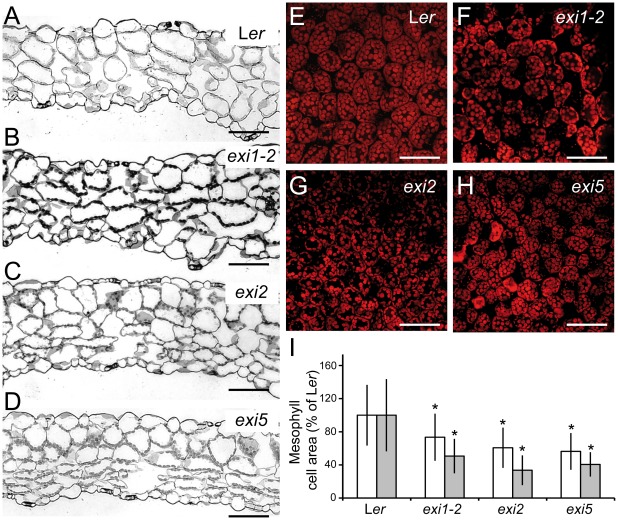
Internal leaf structure in the exi mutants.(A–D) Transverse sections of a region midway between the midvein and the leaf margin from (A) Ler, (B) exi1-2, (C) exi2 and (D) exi5 third-node vegetative leaves. (E–H) Confocal micrographs of palisade mesophyll sections of first-node leaves from (E) Ler, (F) exi1-2, (G) exi2 and (H) exi5 mutants. (I) Palisade mesophyll cell size in the subepidermal layer of first-node (white bars) or third-node (grey bars) leaves of Ler and exi mutants. Data were normalized with respect to the Ler value and expressed as percentages (mean and standard deviation). Asterisks indicate significant differences from the Ler control (P value<0.05; n = 13–16 individuals). All the data were obtained at 21 DAS from plants grown on half-strength MS agar medium. Scale bars indicate (A–D) 100 µm and (E–H) 50 µm.